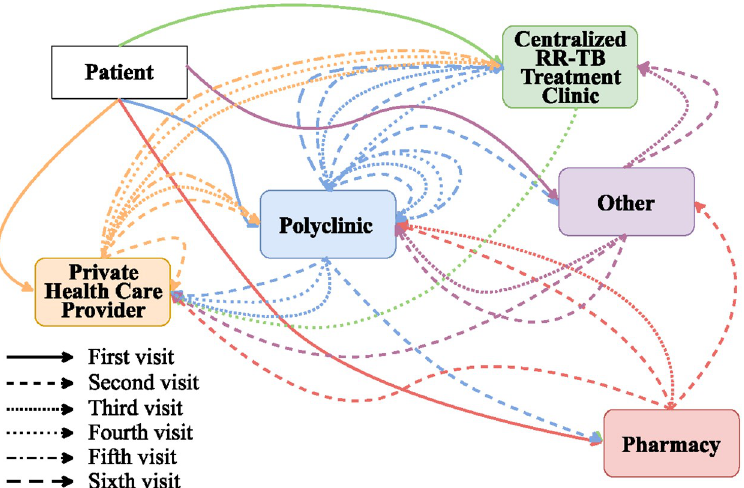
Fig 2. Cyclic care-seeking pathways and repetitive visits followed by study participants. Different colours correspond to the health facility where patients sought care. The different arrows represent successive care-seeking visits as shown in the figure